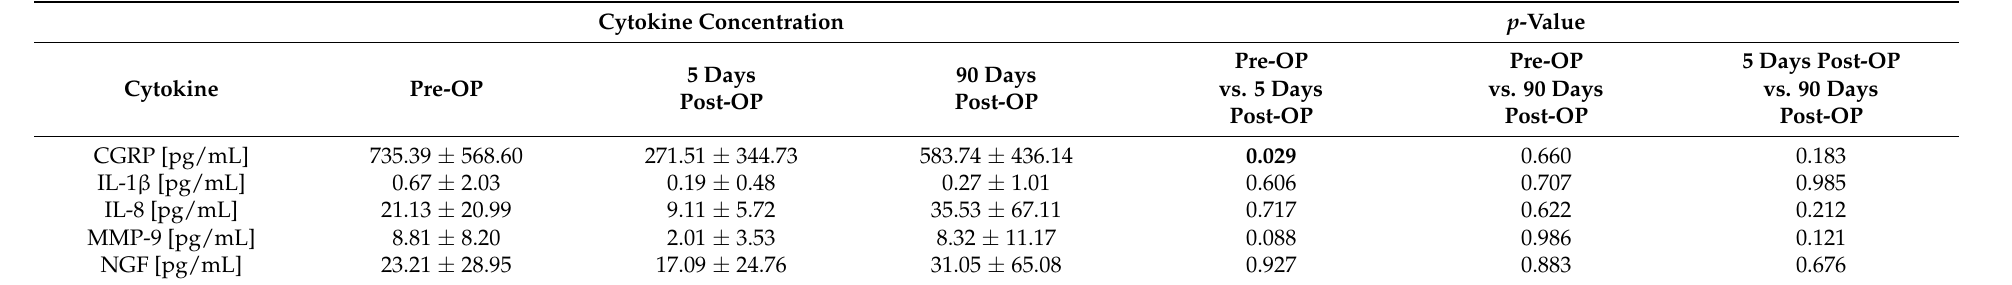
Table 4. Protein concentration in tear film samples before as well as 5 and 90 days after Femto-LASIK, measured via ELISA (mean ± SD). Significant p -values are in bold. Abbreviations: CGRP = calcitonin gene-related peptide; IL = interleukin; MMP-9 = matrix metalloproteinase-9; NGF = nerve growth factor.